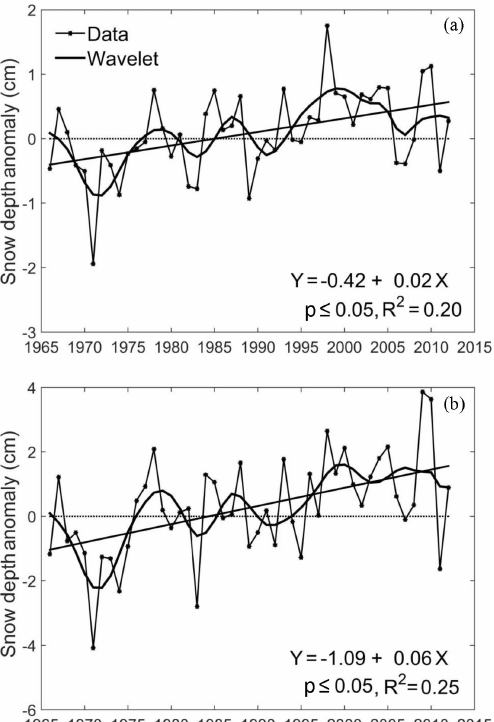
Figure 4. Composite of the anomalies of annual mean snow depth (a) and annual maximum snow depth (b) from 1966 through 2012 with respect to the 1971–2000 mean across the Eurasian continent. The composite anomaly was calculated by the sum of anomalies from all stations divided by the number of sta- tions at a given year. The line with dots is the anomaly of snow depth. The thick curve represents the smoothed curve using wavelet analysis. The thick line presents a linear regression